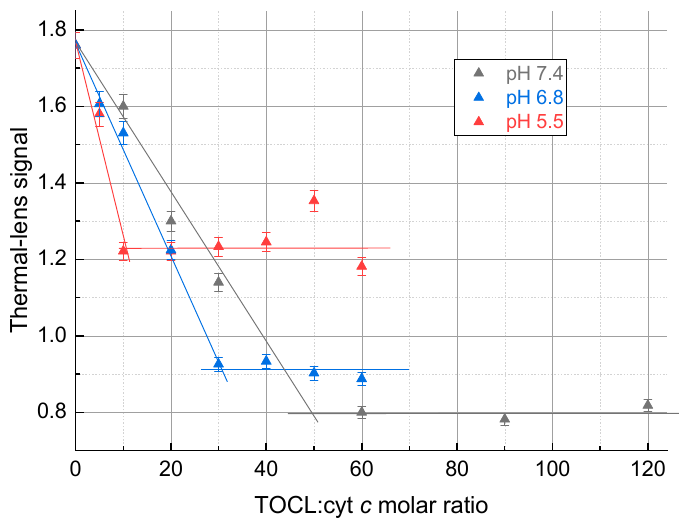
Figure 2. Thermal lens signal of aqueous solutions of the ferricytochrome c (4.0 µM) complex with TOCL on the TOCL:Cyt c molar ratio at different pHs. Excitation, 514.5 nm, 40 mW.